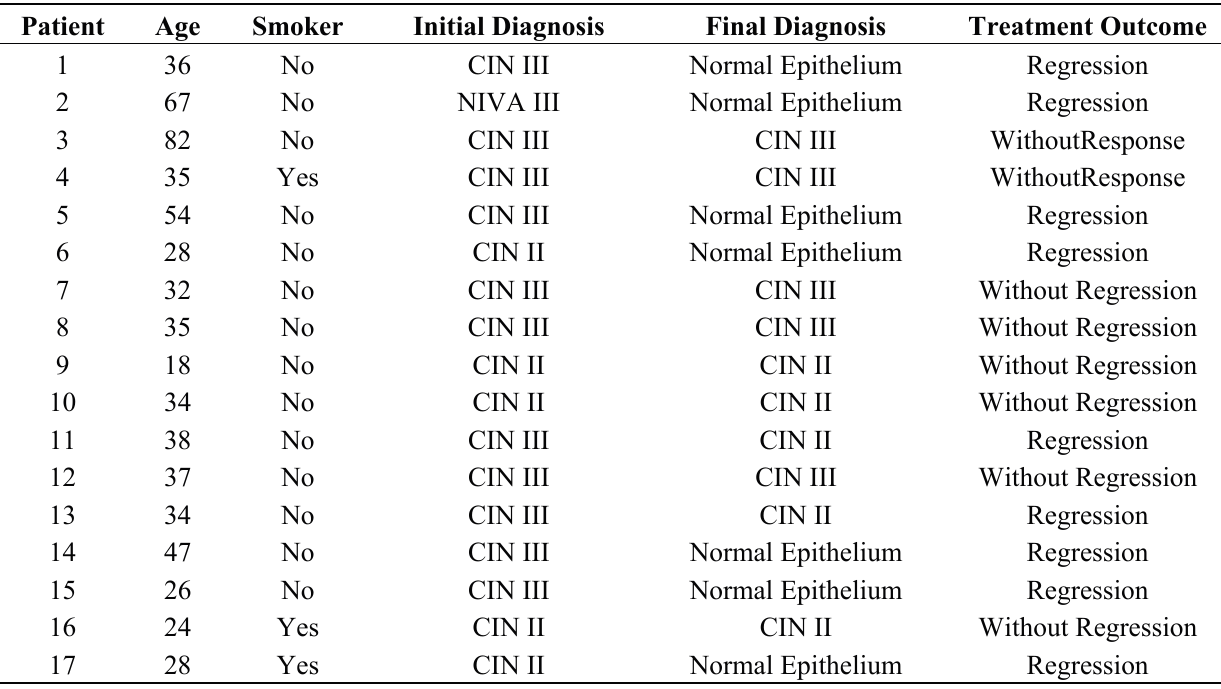
Table 1. Clinical charateristics, histological diagnosis by biopsy, and conduct in each case, after immunotherapy with pegylated IFN- α